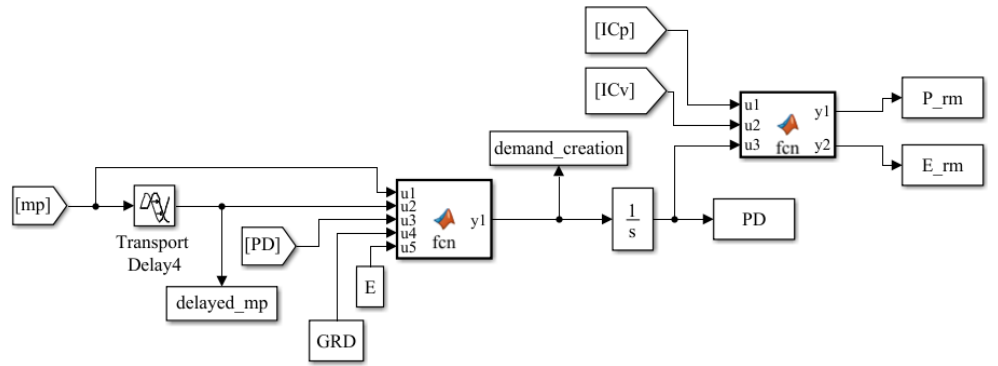
Figure A2. Demand component. Reprinted with the permission of Reference [13]. Copyright 2018